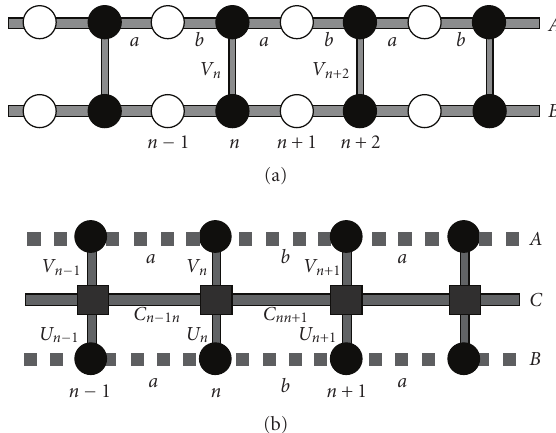
Figure 10: Models of the double strand of DNA. (a) The two-chain model and (b) the three-chain model we adapted in the main